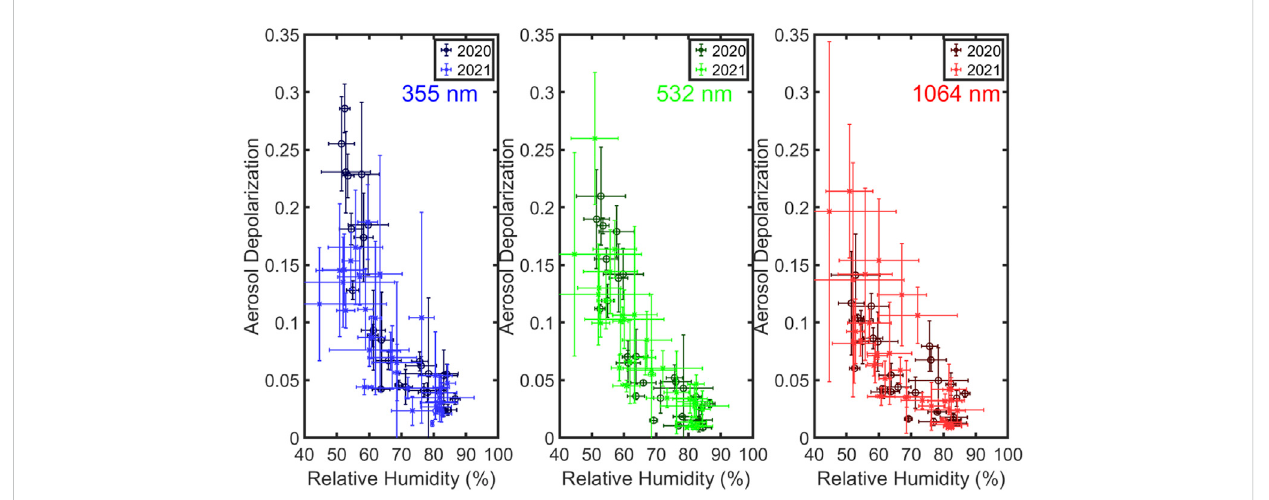
FIGURE 8 Dropsonde RH measurements and coincident HSRL-2 aerosol depolarization measurements at 355 nm (left), 532 nm (center), 1,064 nm (right) during 63 fl ight days conducted in 2020 and 2021. Each point represents the average over the lowest 20% of the mixed layer (i.e., approximately the lowest 200 – 300 m).